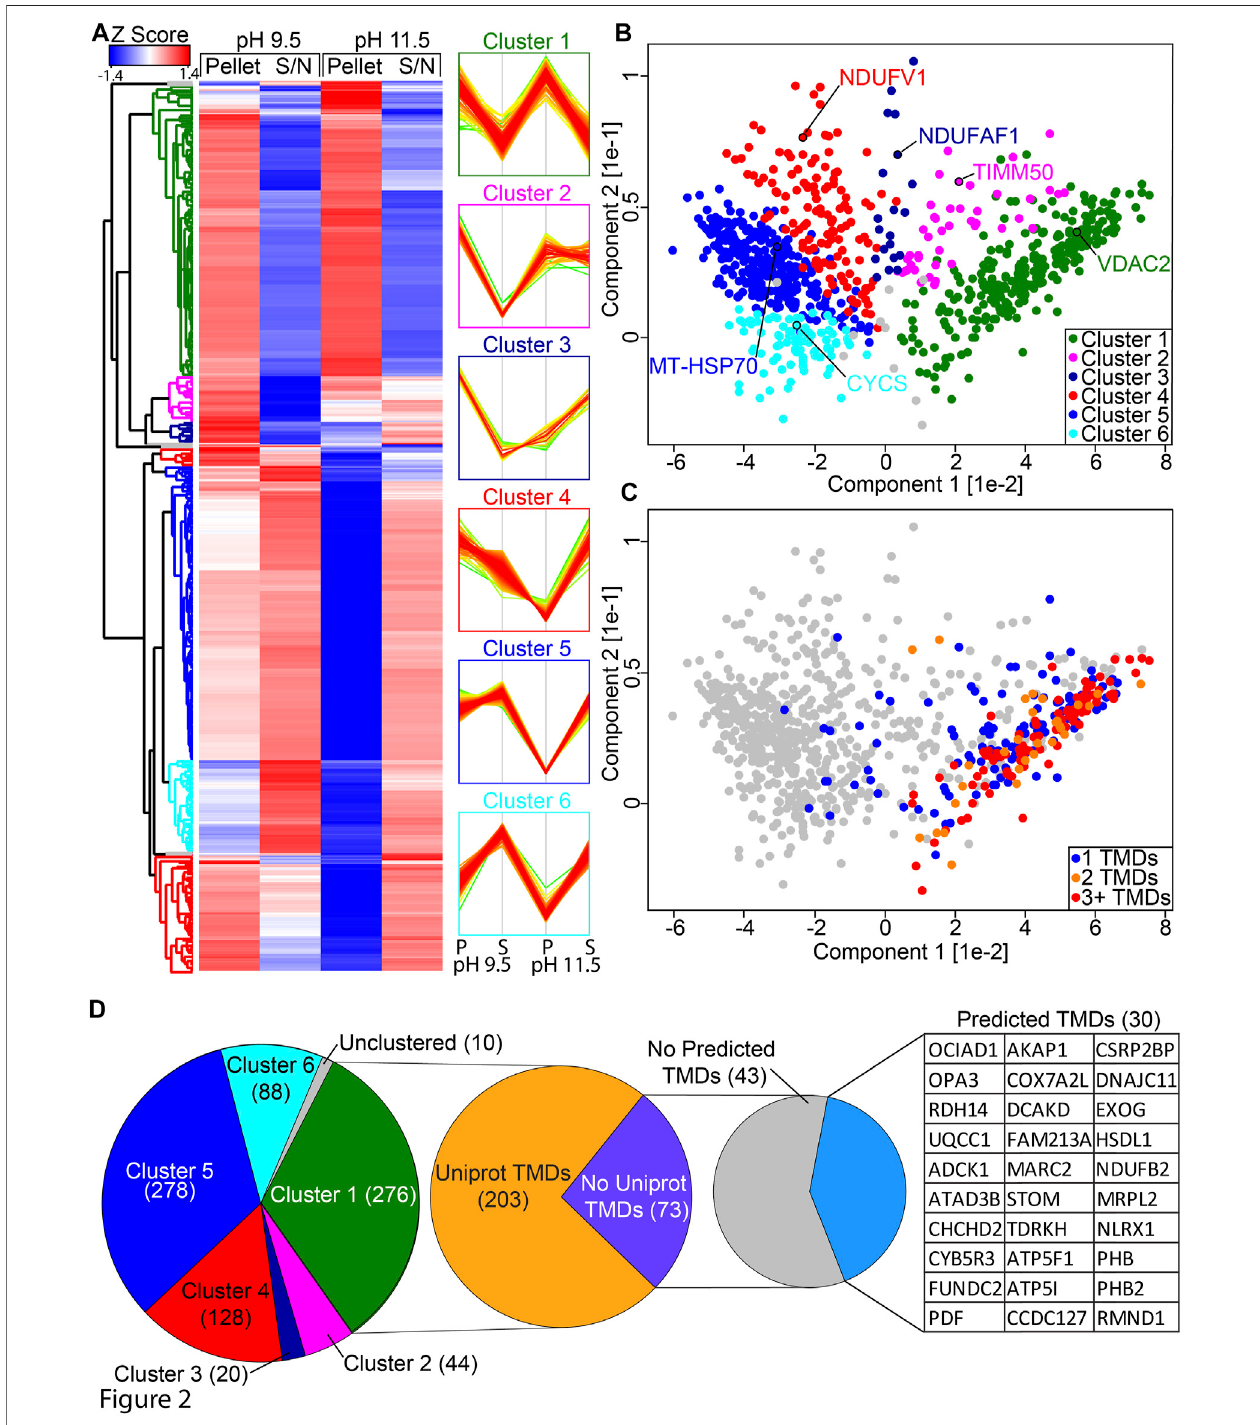
FIGURE 2 | Classi fi cation of protein clusters. (A) HEK293T mitochondrial proteome SCE-MS data was Z-scored and hierarchical clustering was performed. Results are expressed in a heatmap and the pro fi les of each cluster are shown. The x -axis on the pro fi les indicates relative abundance, where higher is equal to more abundant.Coloringre fl ectsdistancetothemeanofthepro fi le,whereredisclosest,greenismostdistant. (B) PrincipalcomponentanalysisofHEK293Tsupernatantand pellet fractions at pH 9.5 and 11.5, colored according to the clusters identi fi ed in (A) . (C) as for B but with coloring according to the number of transmembrane domains. (D) Breakdown of Cluster 1 showing number of proteins with TMDs annotated in Uniprot and predicted by at least two single TM prediction algorithms (TMPred, HMMTOP, TMHMM or Phobius).